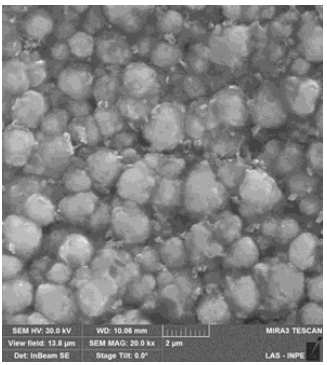
Figure 7. SEM ‐ FEG Micrograph of NbN coating exposed to palm biodiesel at 1320 h.